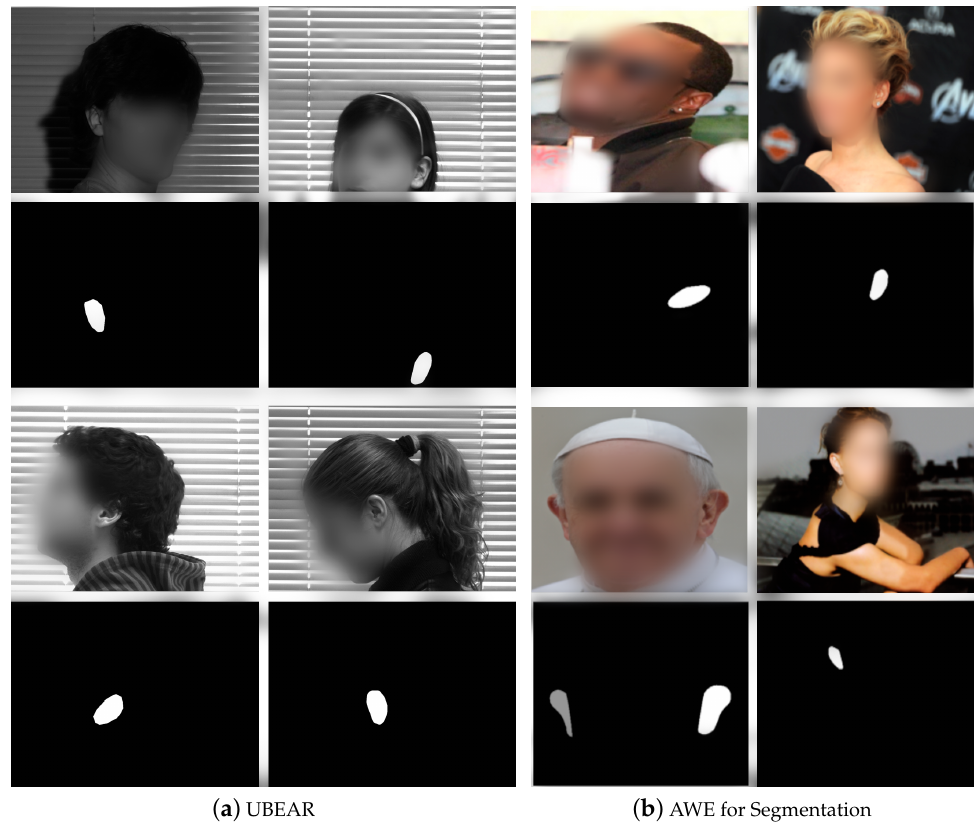
Figure 2. Ear segmentation datasets samples. Pictures of every person are over their own ear segmentation image (mask image). ( a ) UBEAR dataset contains images taken within the same environment and specific head positions for everyone. ( b ) AWE dataset gathers images with high variation and in some cases, the two ears are present in the